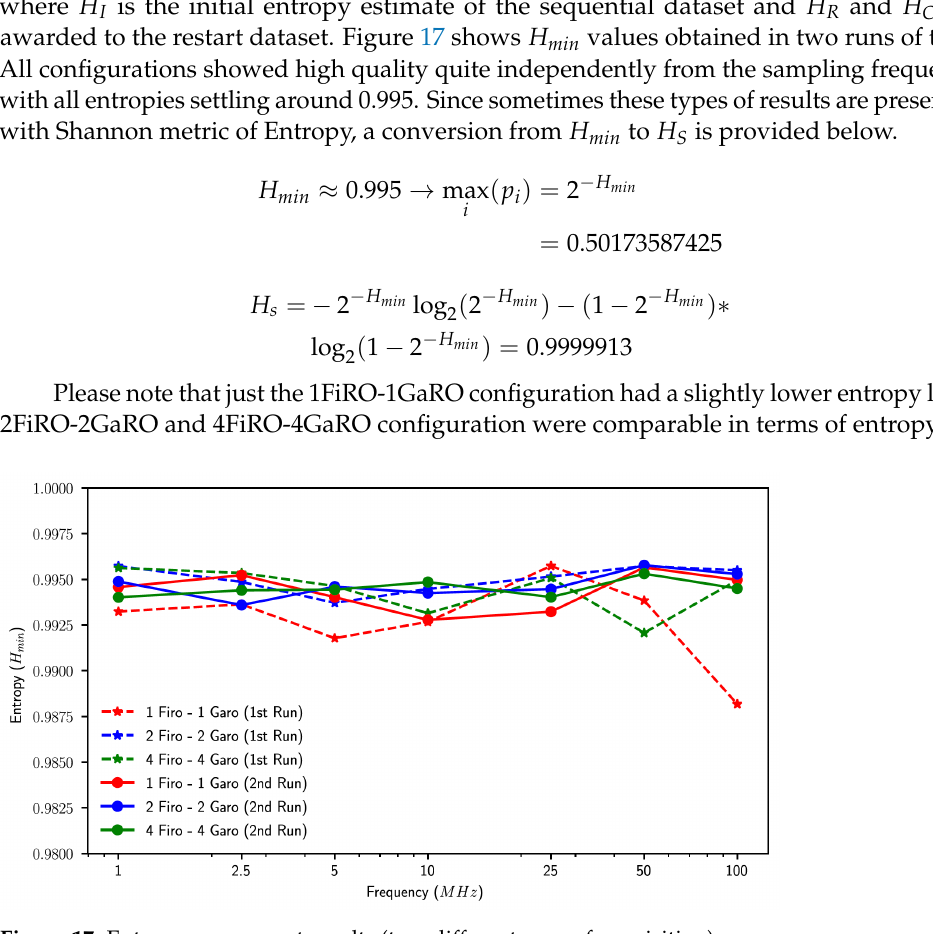
Figure 17. Entropy assessment results (two different runs of